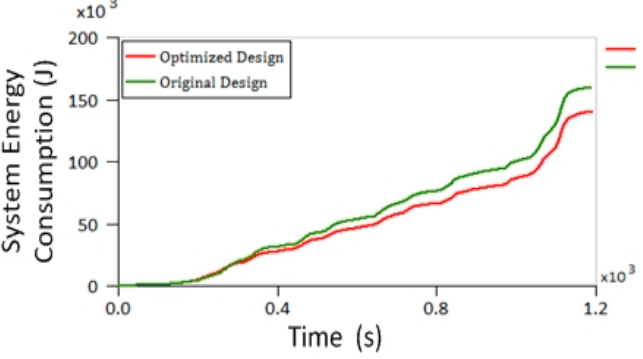
Figure 30. System energy consumption optimization.